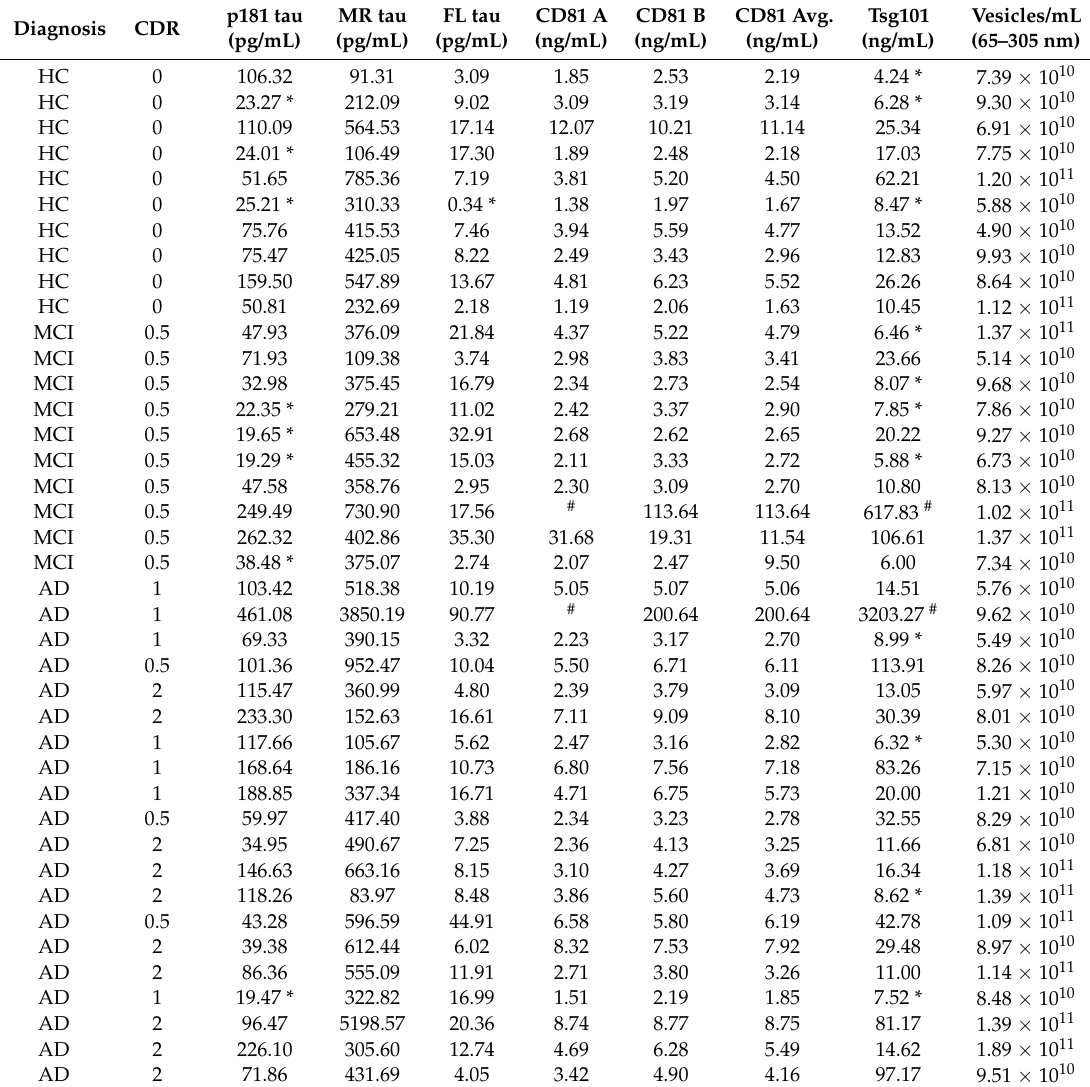
Table 2. Raw values for all assays ordered by diagnostic